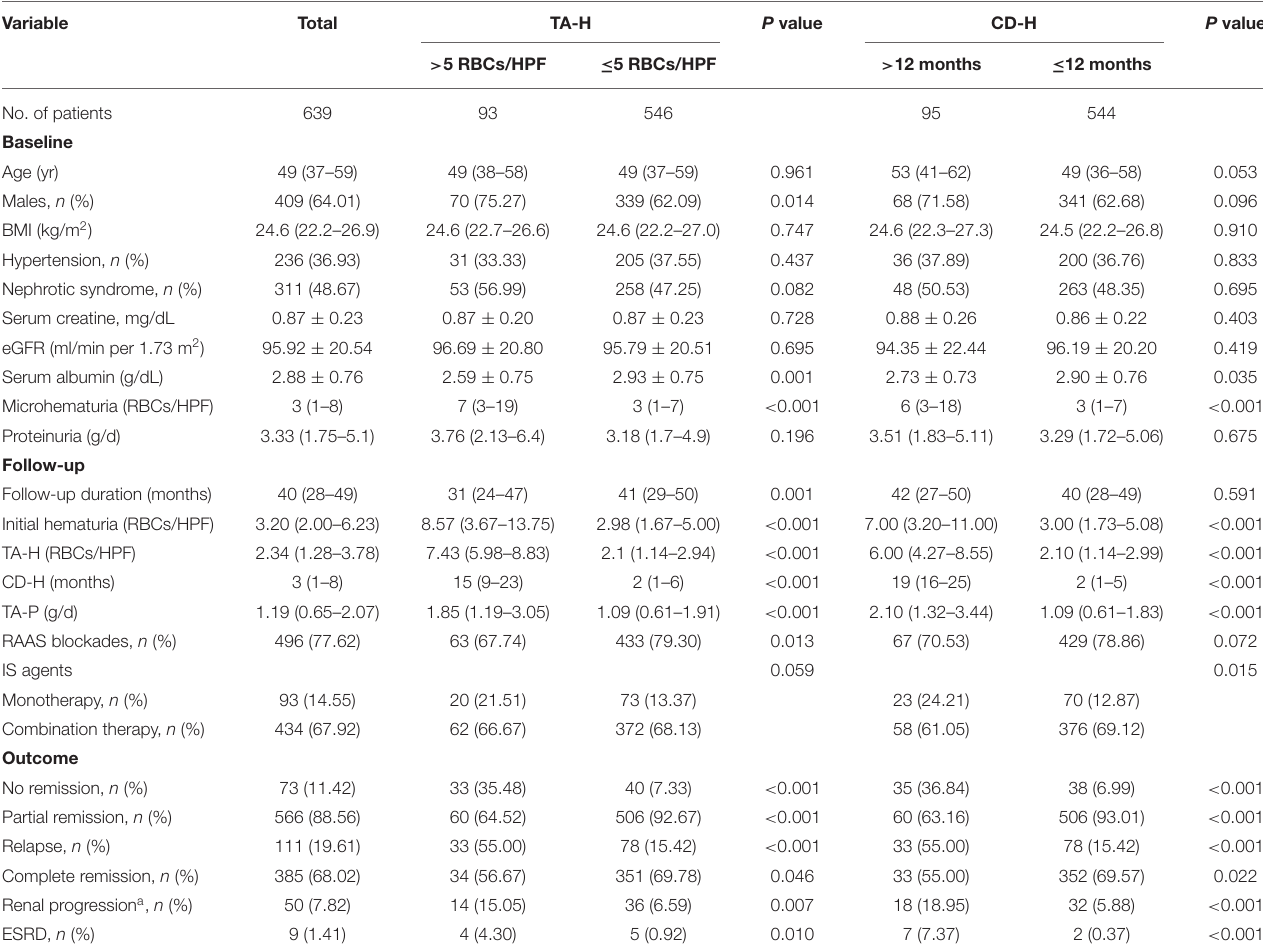
TABLE 1 | Characteristics of patients with primary membranous